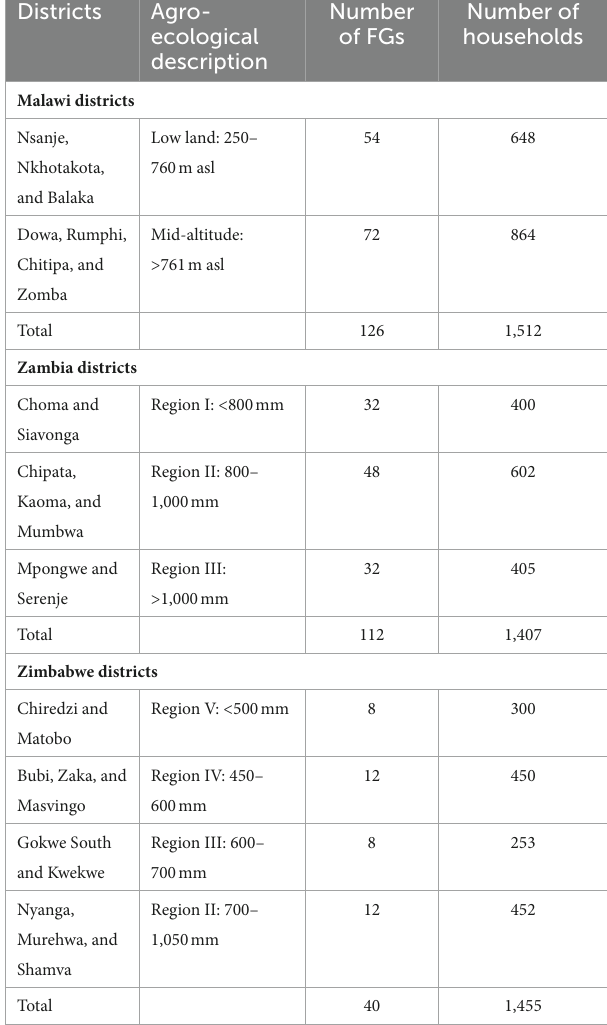
TABLE 1 Sample size distribution by district and agro-ecological zone. Districts